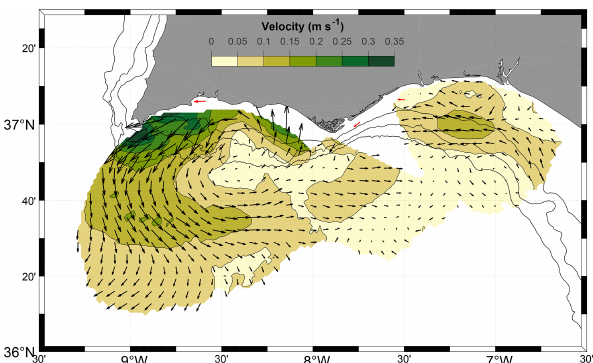
Figure 14. Conditioned mean map computed from periods in June to October with mode 2 phase between − 65 and 65 ◦ and the ratio of mode 1 and mode 2 amplitudes ≤ 2. For clarity, arrows are repre- sented every four grid nodes. Red arrows indicate the mean velocity computed from available ADCP data for the same